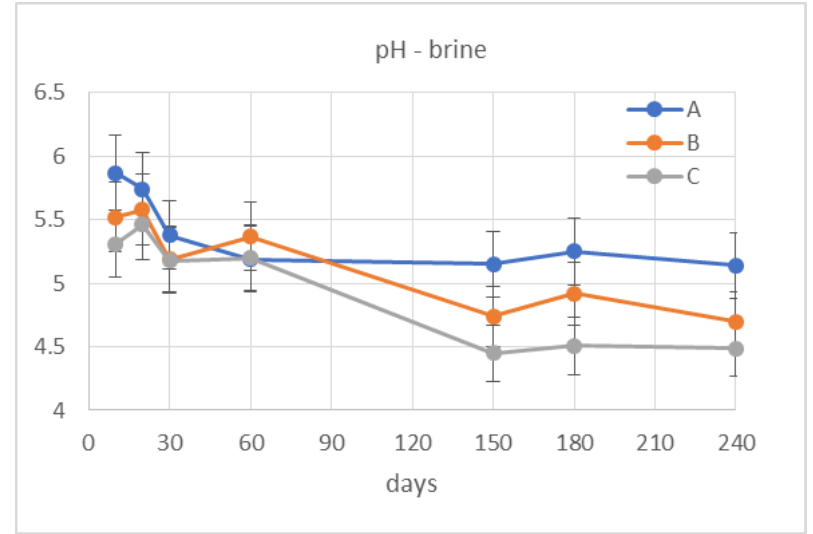
Figure 4. Evaluation of the pH in the brine during the fermentation. A = spontaneous; B = inoculated with L. plantarum B1; C = inoculated with L. plantarum B1 + B51 + B124. The data are expressed as the mean of two replicates ± standard deviation.